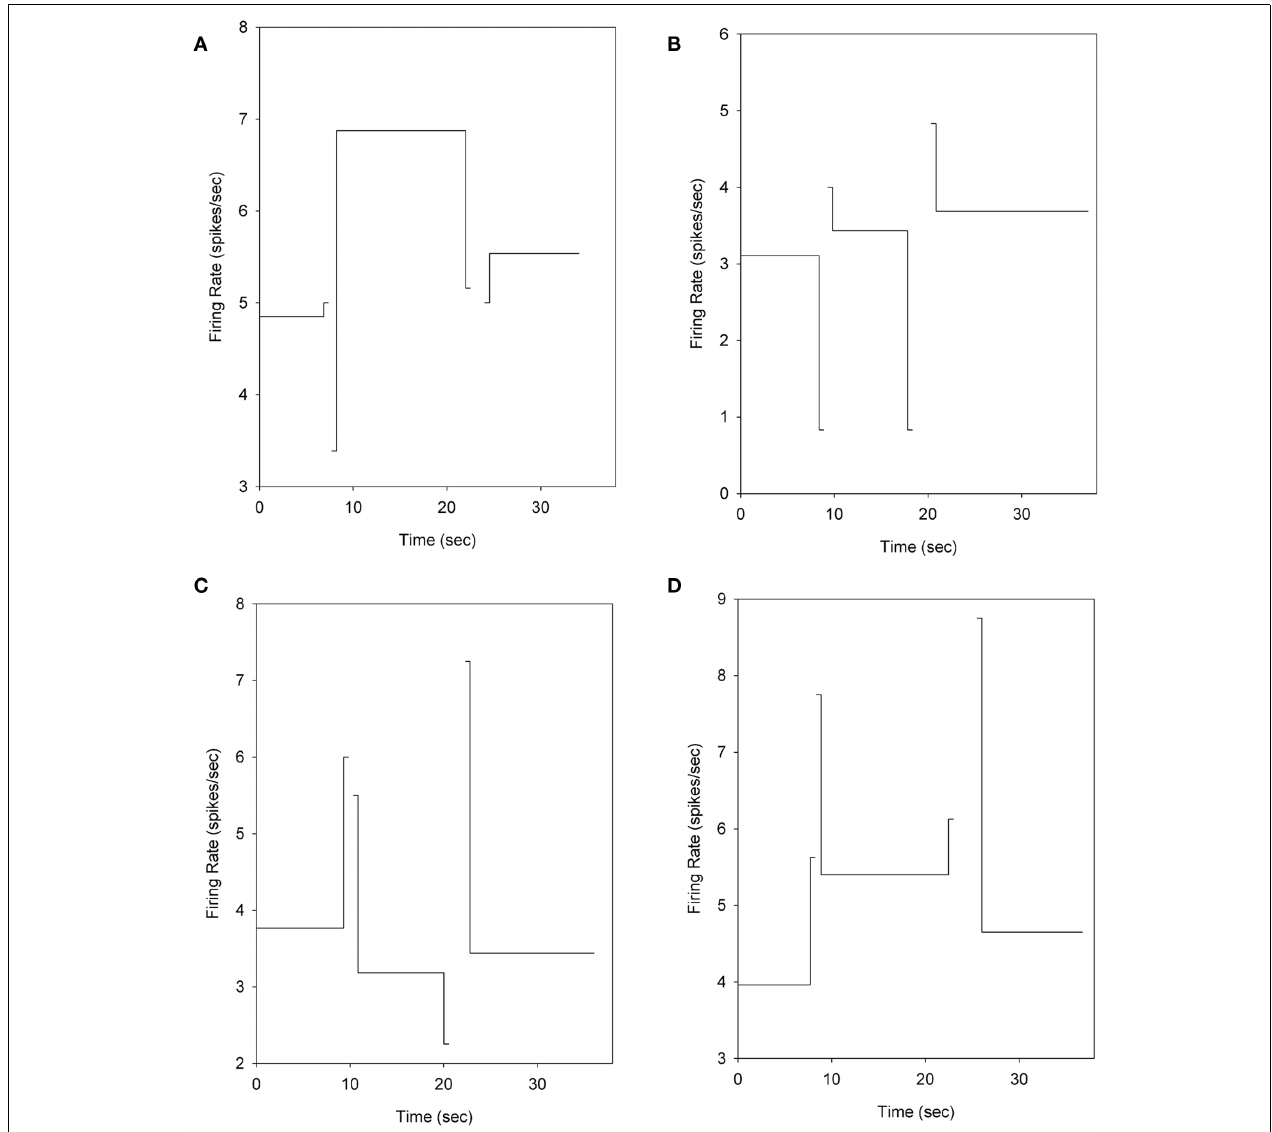
a trial-by-trial basis to eliminate the temporal variability of each phase as it relates to trial onset.To facilitate display, the duration of the transition segments is shown over 500ms, rather than the 200ms used for analysis. The neurons in panels (A–D) are the same neurons shown in Figures 4A–D